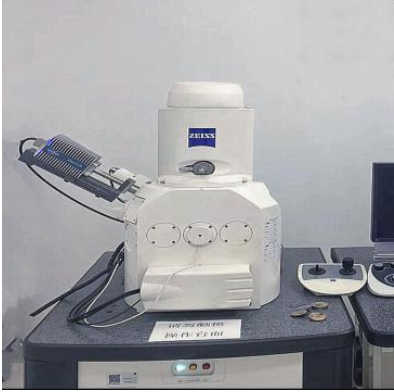
Figure 7. GeminiSEM 360.